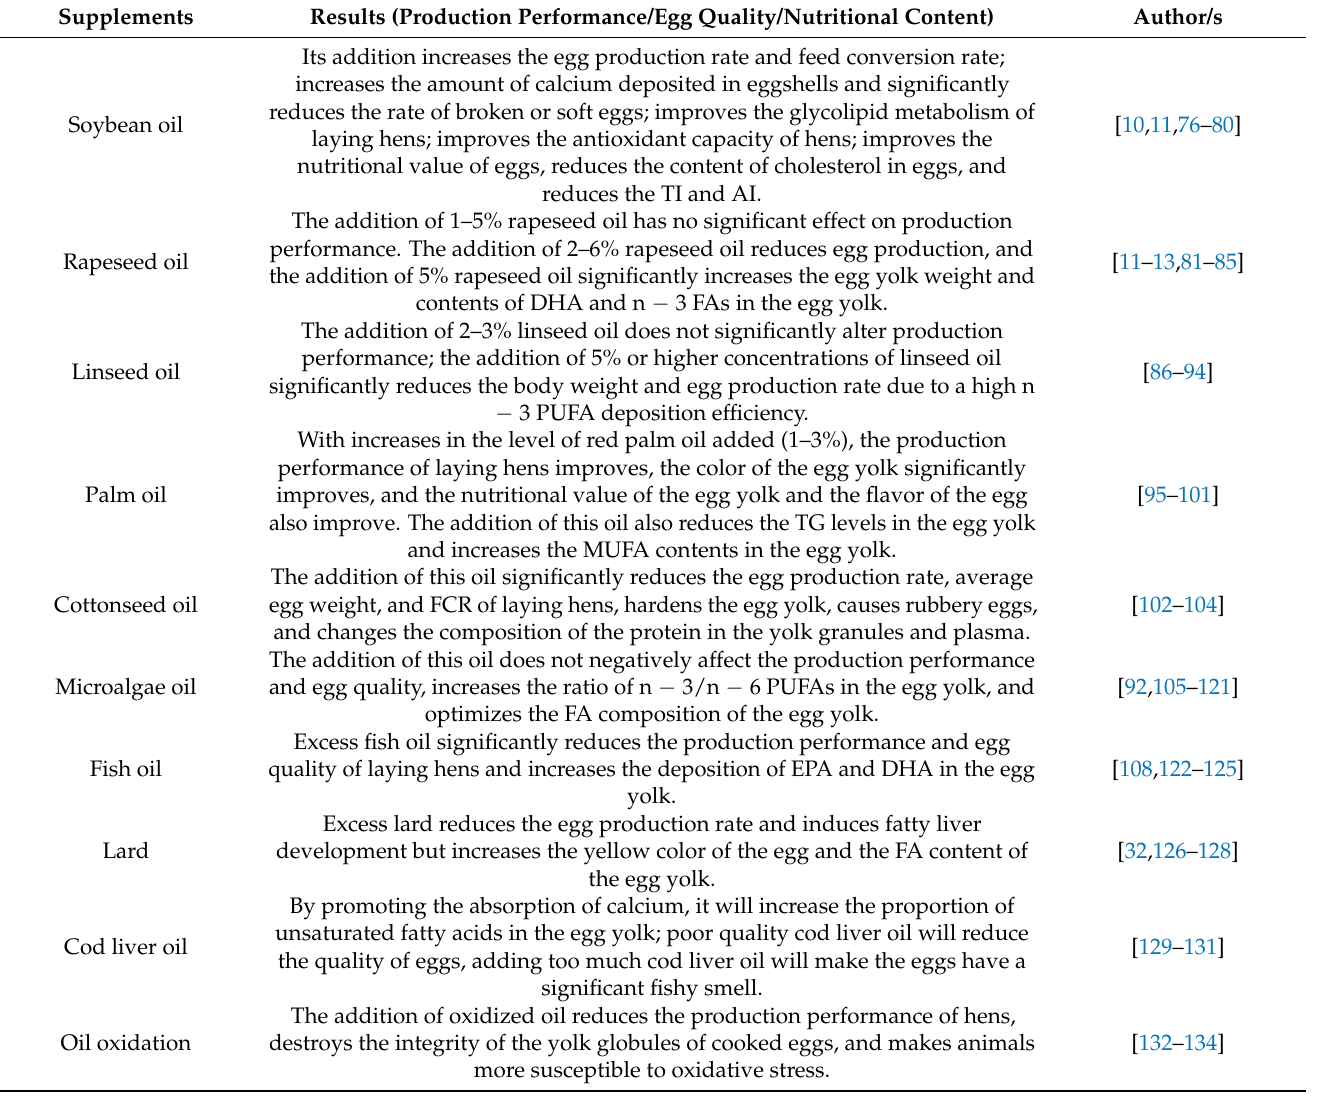
Table 1. Studies showing the effects of different oils on egg quality and production performance. Results (Production Performance/Egg Quality/Nutritional